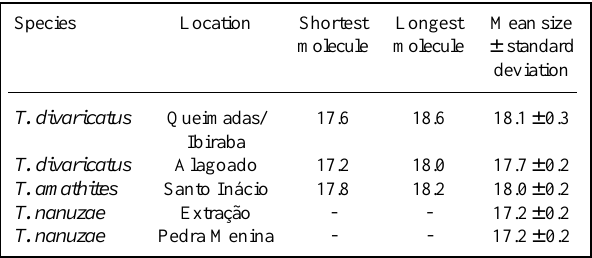
Table IV - Approximate sizes (kb) of the mtDNA molecules in the Tropidurus populations